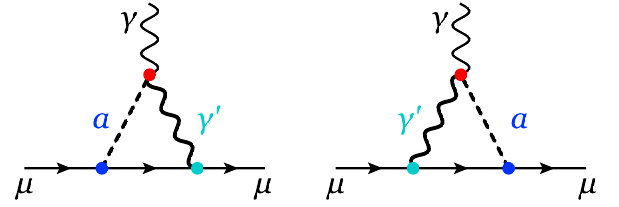
as a function of the ALP mass m a , the dark photon mass m γ (cid:3) , and the muon mass m μ . The dark axion portal